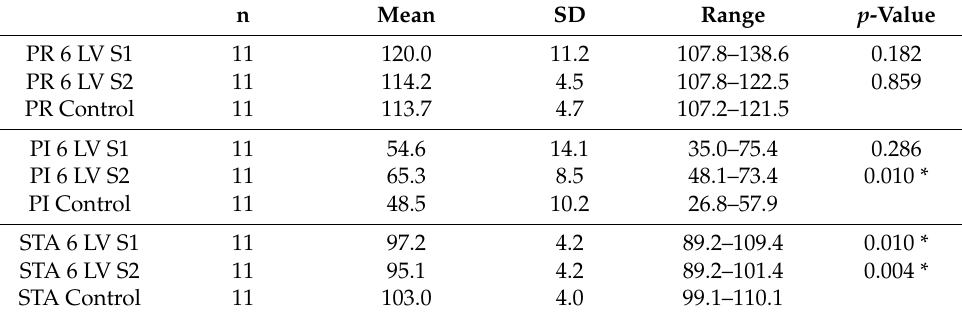
Table 3. Comparison between the LSTV subgroup with 6 lumbar vertebrae ( n = 11) measured at S1 (6 LV S1) and S2 (6 LV S2) and the matched control group ( n = 11), in terms of PR (pelvic radius), PI (pelvic incidence), and STA (sacral table angle) (SD = standard deviation). p -values are defined between the matched control group and the respective measurement point, with * indicating a significant difference. The significance level was assessed at p <